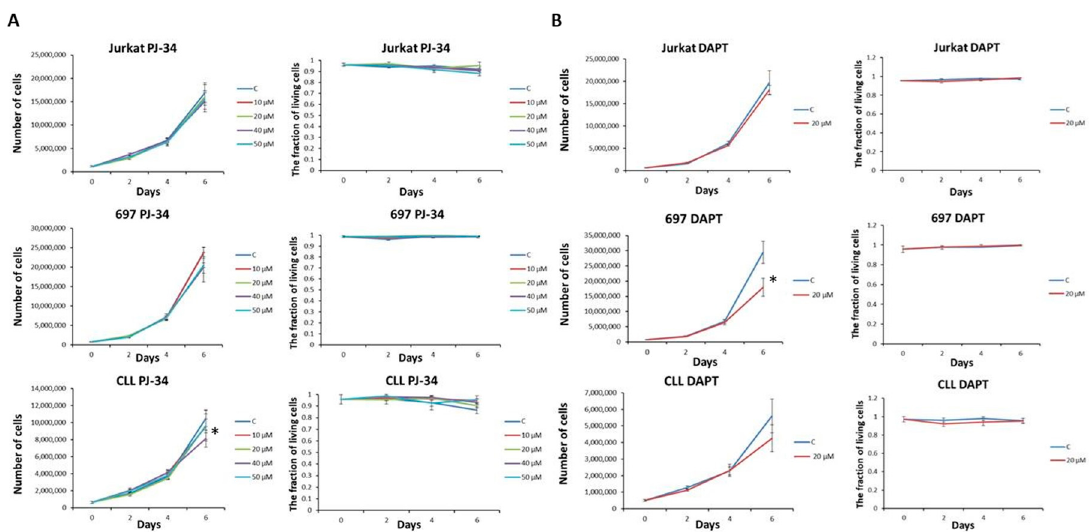
Figure 2. Influence of PJ-34 and DAPT inhibitors on proliferation and viability of leukemic cell lines. Jurkat, 697 and CLL cell lines were treated with PARP1 inhibitor PJ-34 ( A ) and Notch inhibitor DAPT ( B ) every second day, for six days. Total cell number and the fraction of living cells were obtained by counting cells stained with Trypan blue dye under the light microscope. The standard deviation of the four different counts is displayed. C: control cells; 10 µM, 20 µM, 40 µM, and 50 µM: concentrations of the treating agent; * p -value < 0.05.